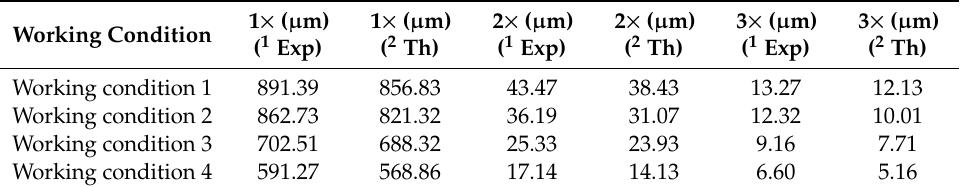
Table 4. Vibration control under di ff erent working conditions in time domain